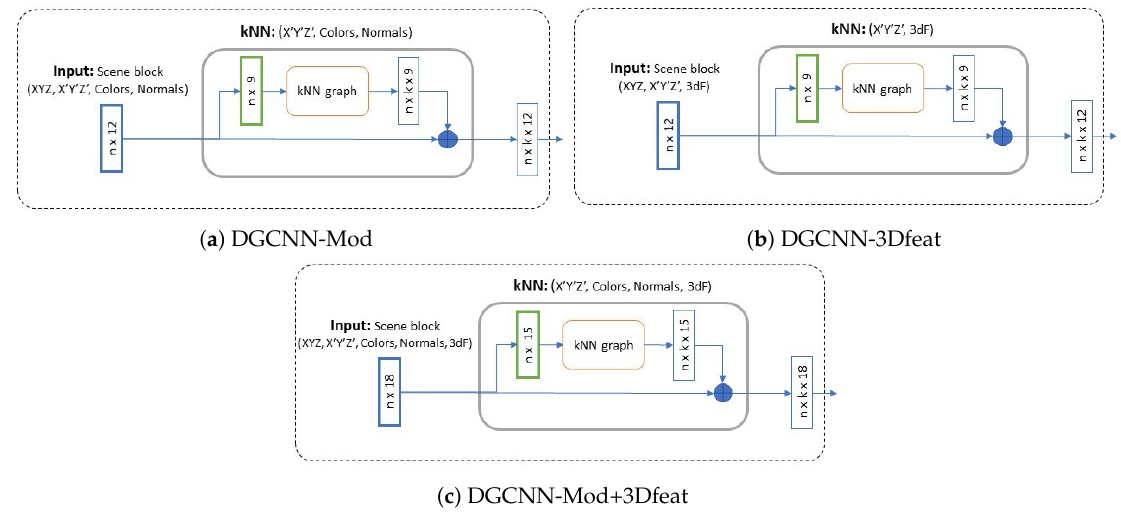
Figure 3. Modified EdgeConv layer for DGCNN-based